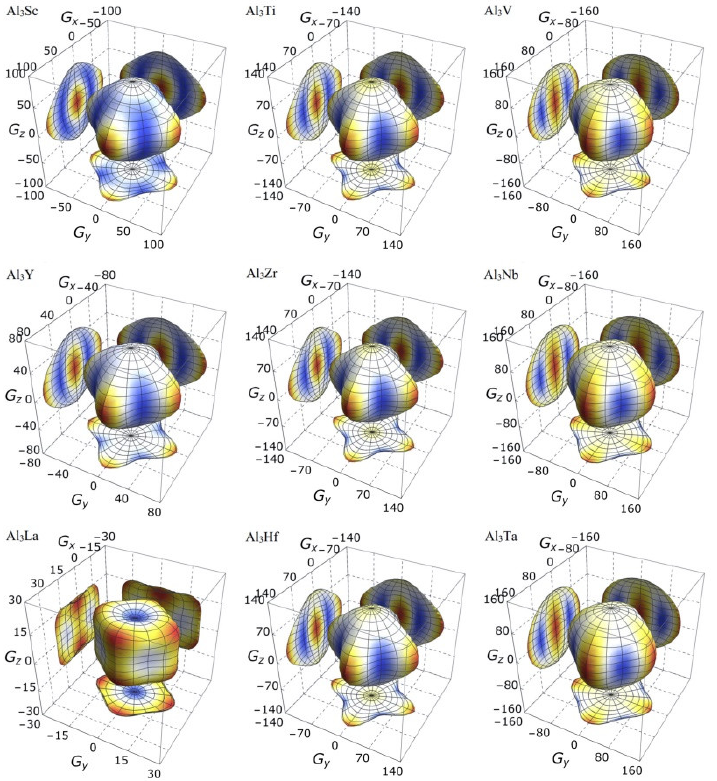
Figure 6. The anisotropic characteristics of shear modulus of the Al 3 TM compounds.